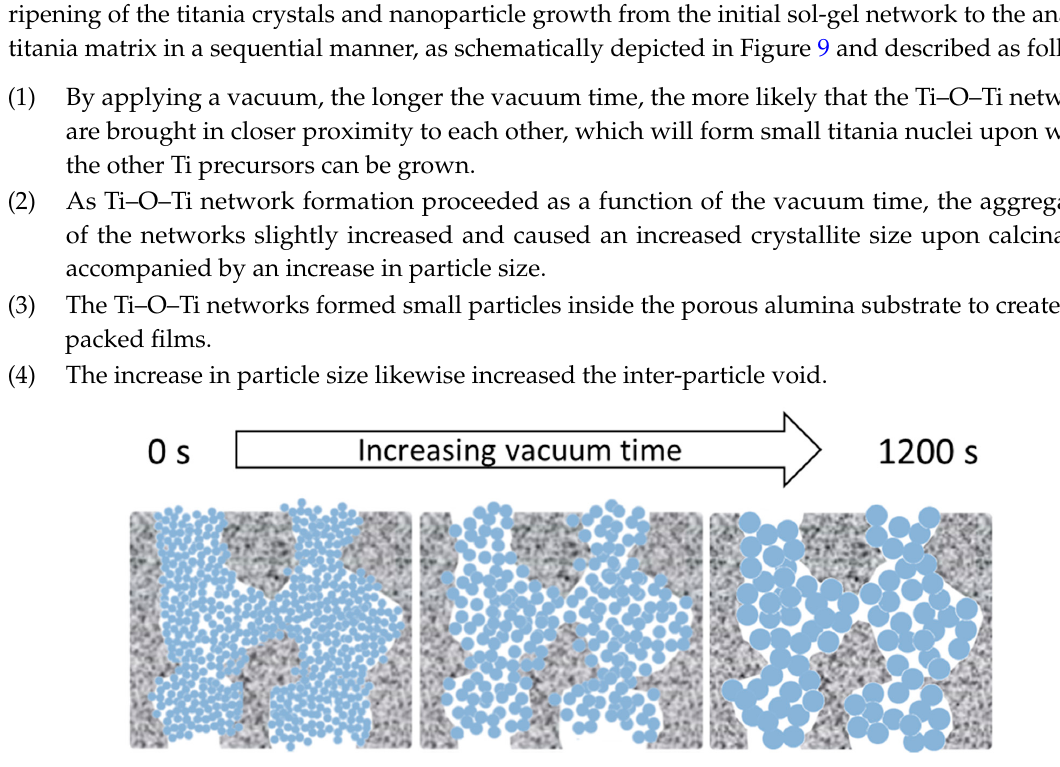
Figure 9. Schematic of the effect of the vacuum in the formation of titania films.